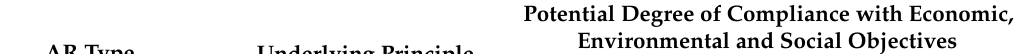
Table 1. Potential e ff ectiveness of artificial reefs (ARs) in terms of economic, environmental and social objectives. Expected results that should be demonstrated by using scientific